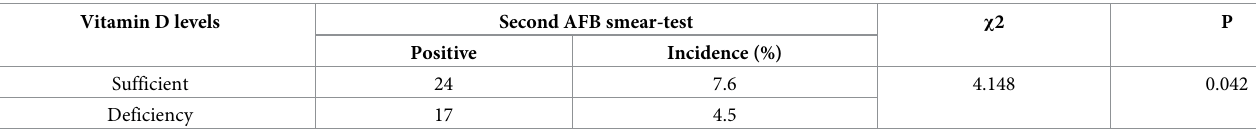
Table 3. Second AFB smear-test results of TB patients with different vitamin D levels. Vitamin D